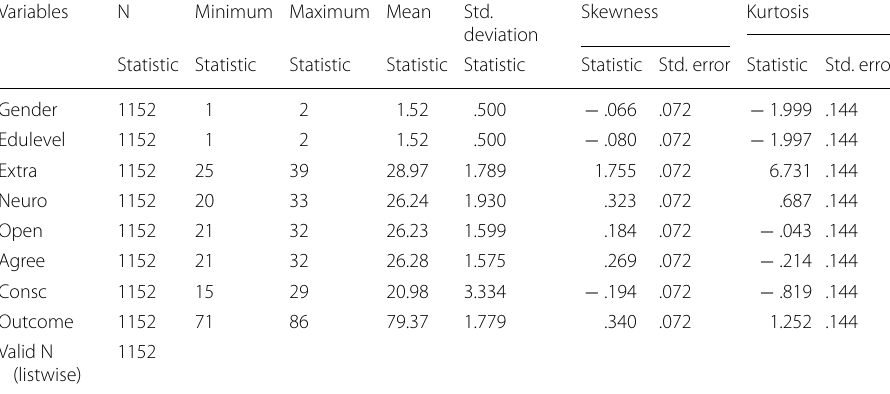
Table 2 Descriptive data analysis